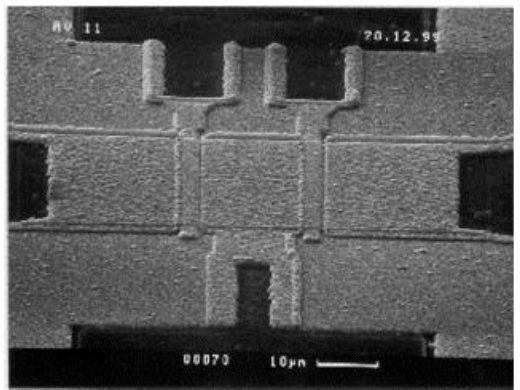
Figure 6. REM image of a two-finger GaN-FET with a 0.7 μm diamond film (deposition temperature 440 °C) [94] .